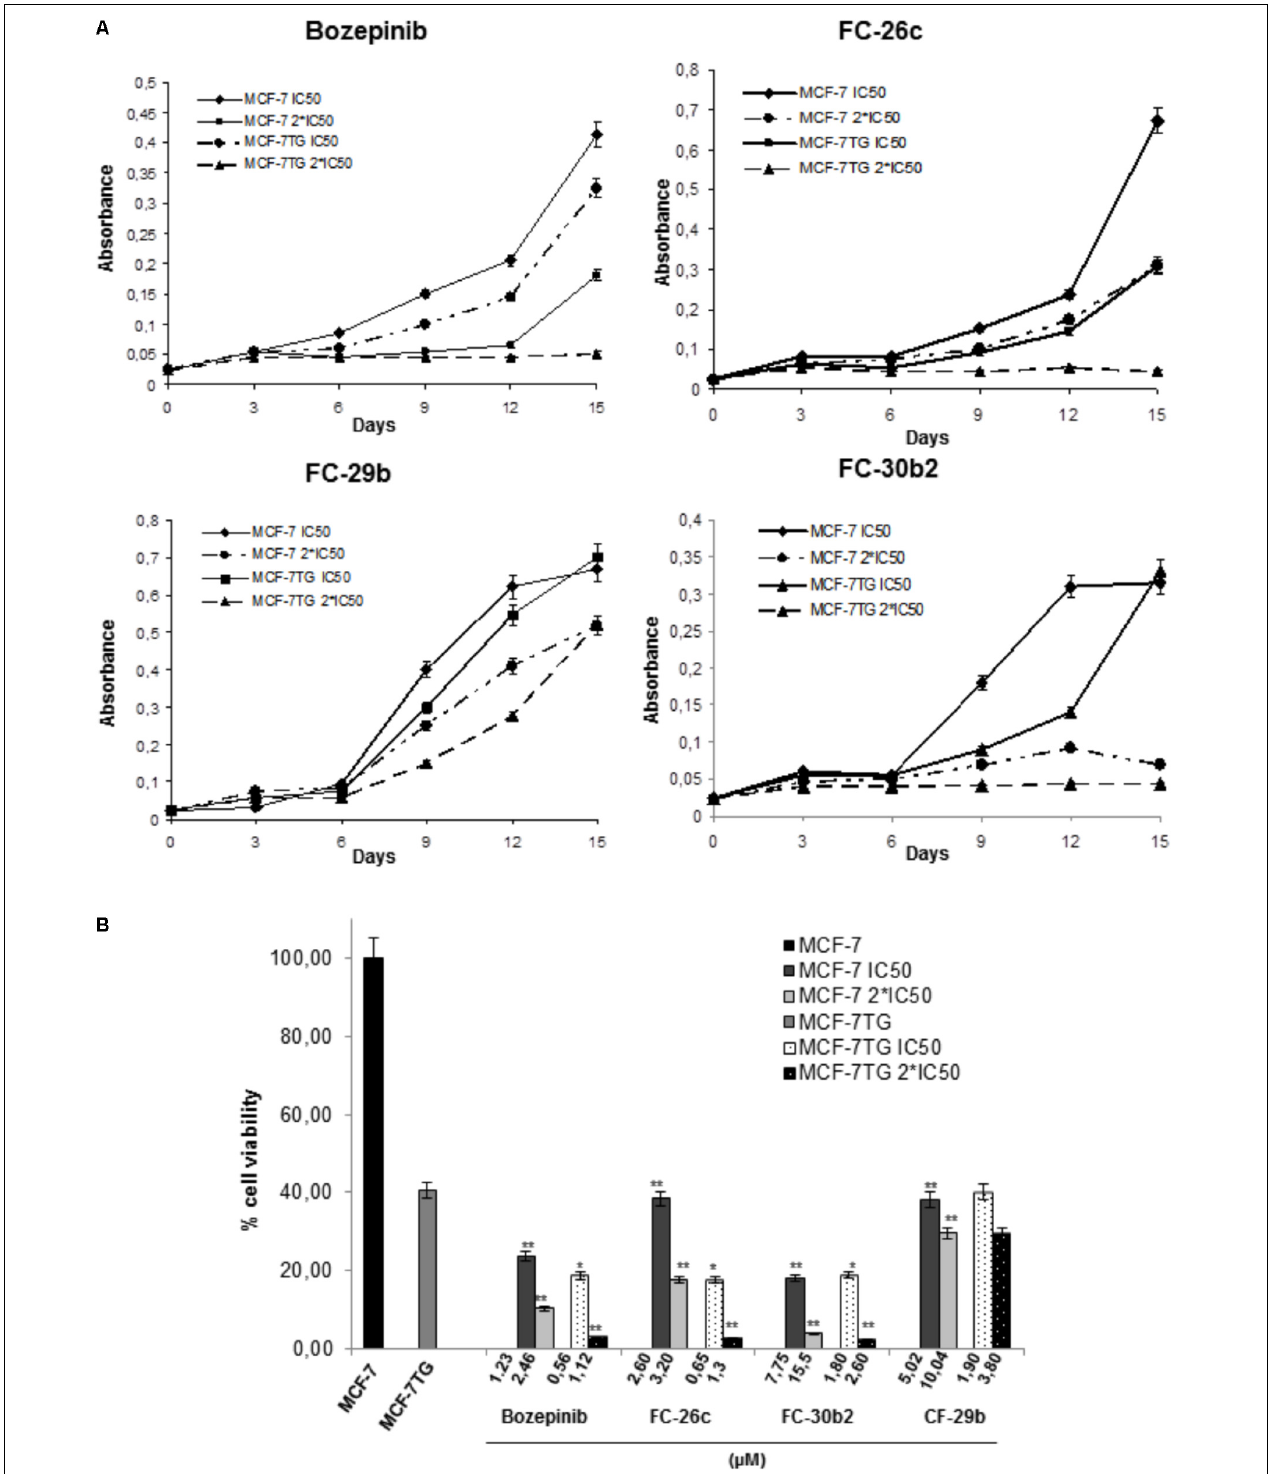
FIGURE 3 | Determination of the effects of the combination of gef gene expression with bozepinib, FC-26c, FC-29b, and FC-30b2 on cell proliferation. (A) MCF-7 and MCF-7TG cell lines were treated with IC 50 and 2 ∗ IC 50 of different compounds during 15 days. Data are expressed as the mean ± standard error of the mean of three independent experiments. (B) Percentage of cell viability after 15 days of treatment with different compounds expressed in comparison to the maximal MCF-7 (100%). The statistical analysis was performed using each cell line without drug exposure as controls. ∗ P < 0.05, ∗∗ P < 0.01 ( t -test).